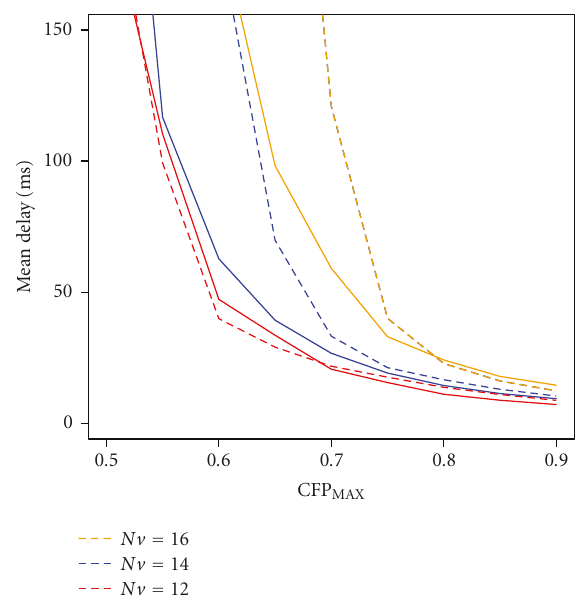
Figure 13: Mean packet delays for a range of voice stations. Solid lines show model predictions, dotted lines show simulated